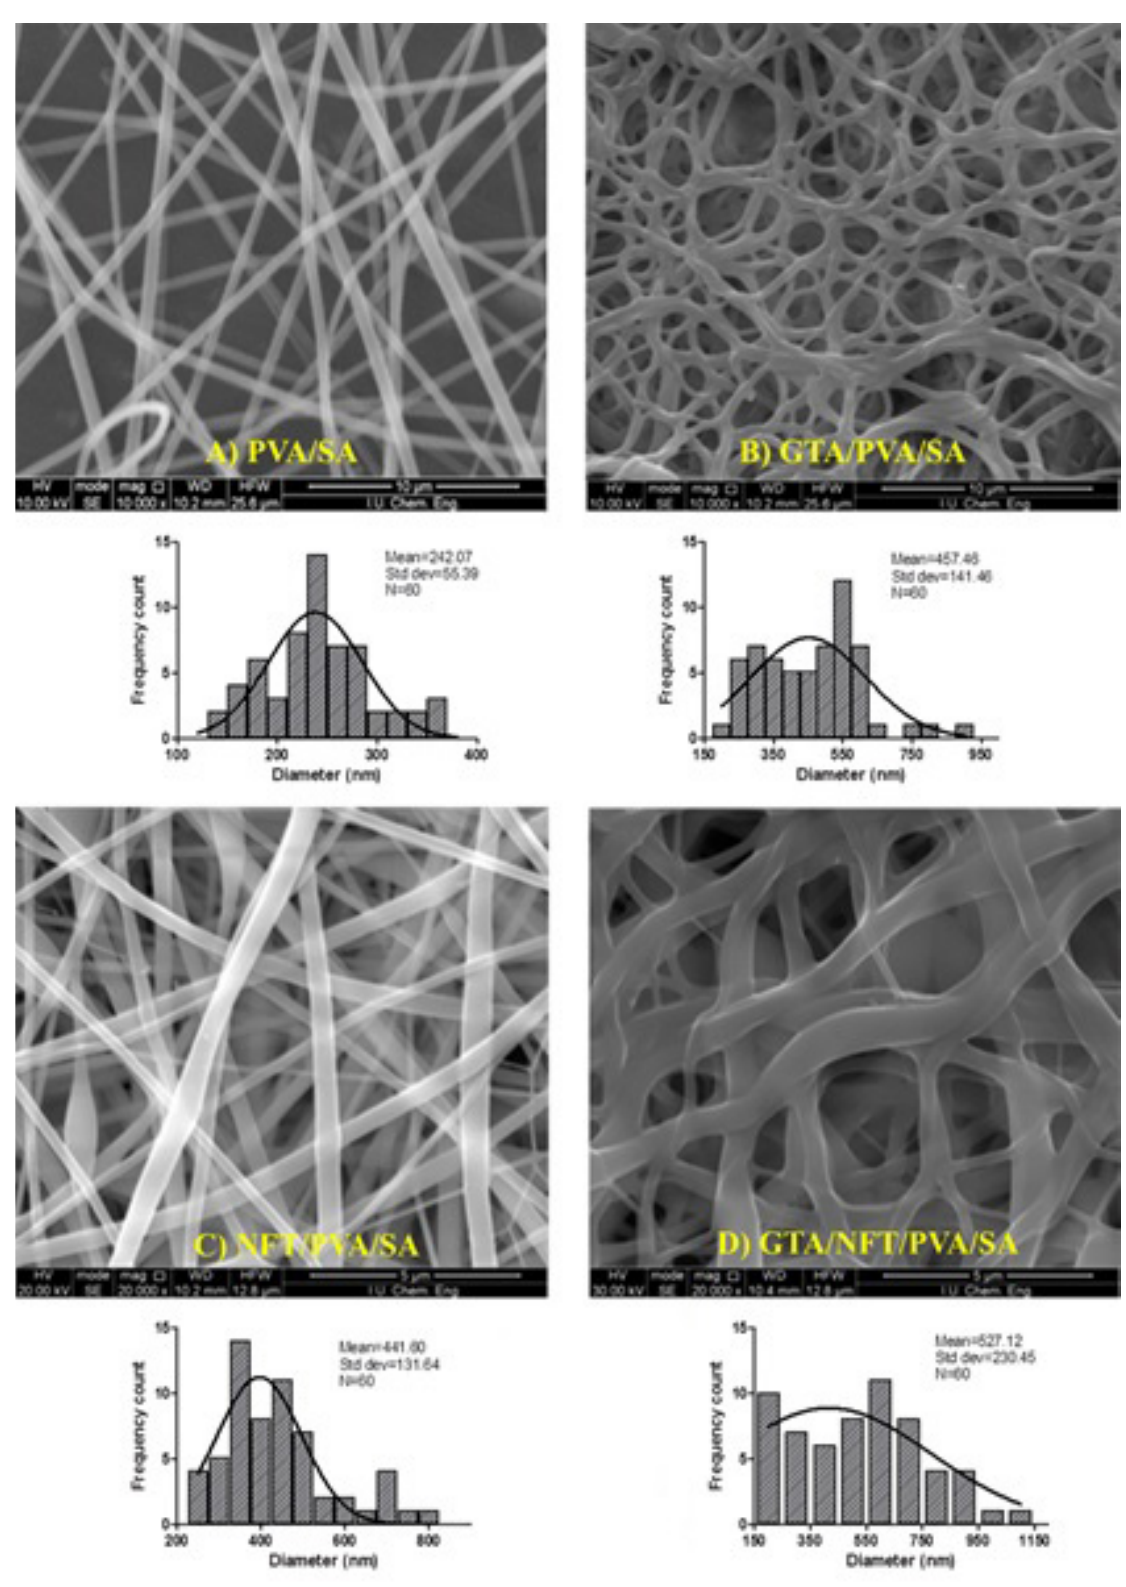
FIGURE 3 - SEM images and fiber size distributions of a) PVA/SA, b) GTA/PVA/SA nanofibers at 10.000x magnification and c) NFT/PVA/SA, d) GTA/NFT/PVA/SA nanofibers at 20.000x